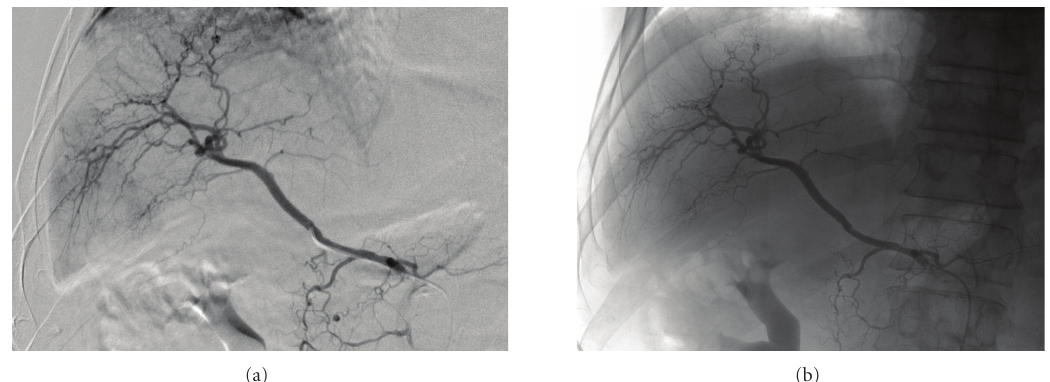
Figure 3: 68-year-old man with hepatocellular carcinoma in segment VI of liver: (a) selective cannulation of right hepatic artery performed demonstrating tumour blush pre-embolisation with (b) absence of this tumour blush post infusion of 40 mg of doxorubicin on 300–500 µ m beads into this